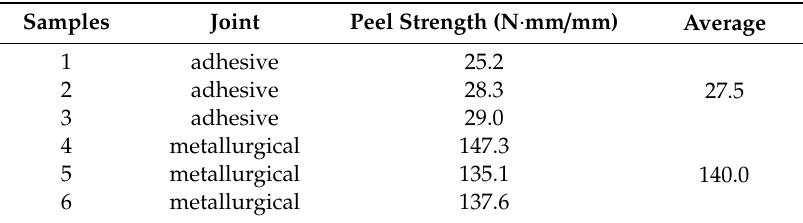
Figure 5. Average peel strength of two types of samples. Table 1. Experimental data for peel strength.